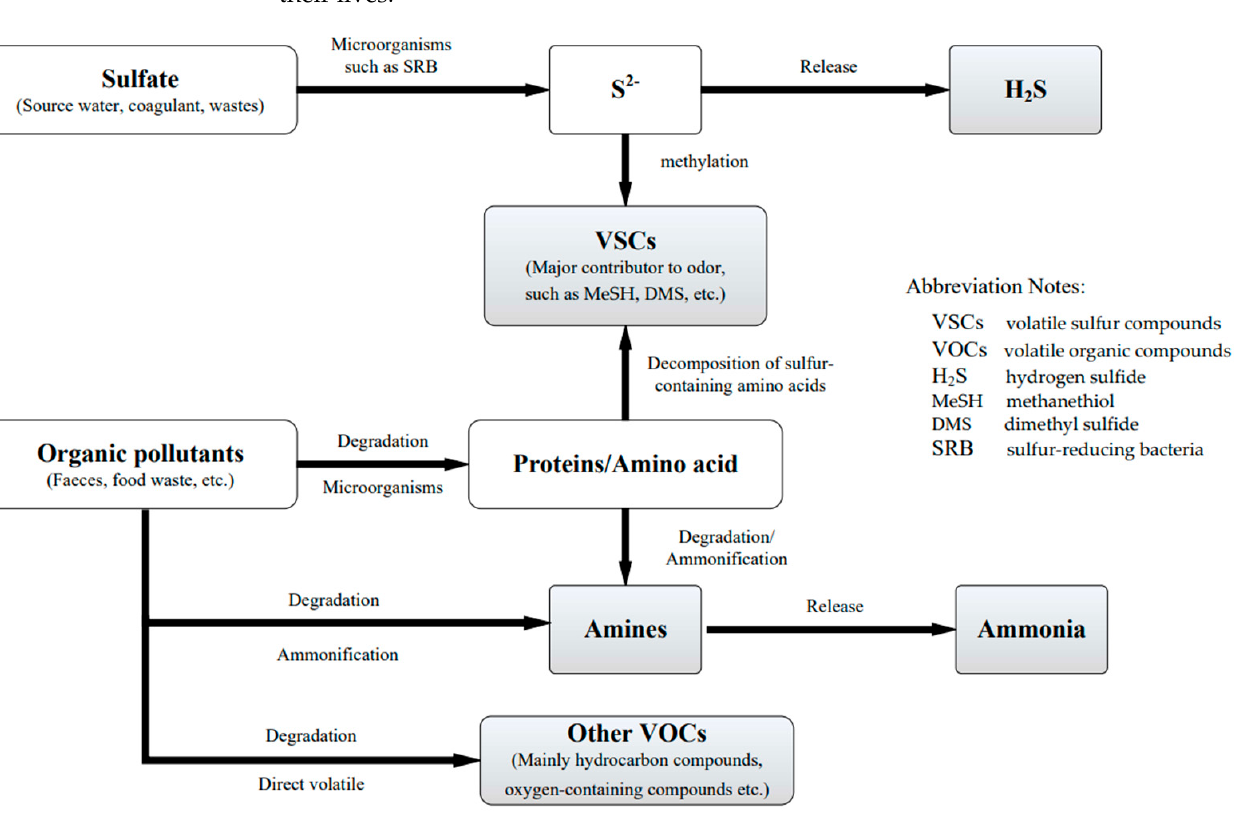
Figure 1. Sources of odorous substances in drainage pipelines (Adapted with permission from Ref. [33], 2020, Cao et al.).